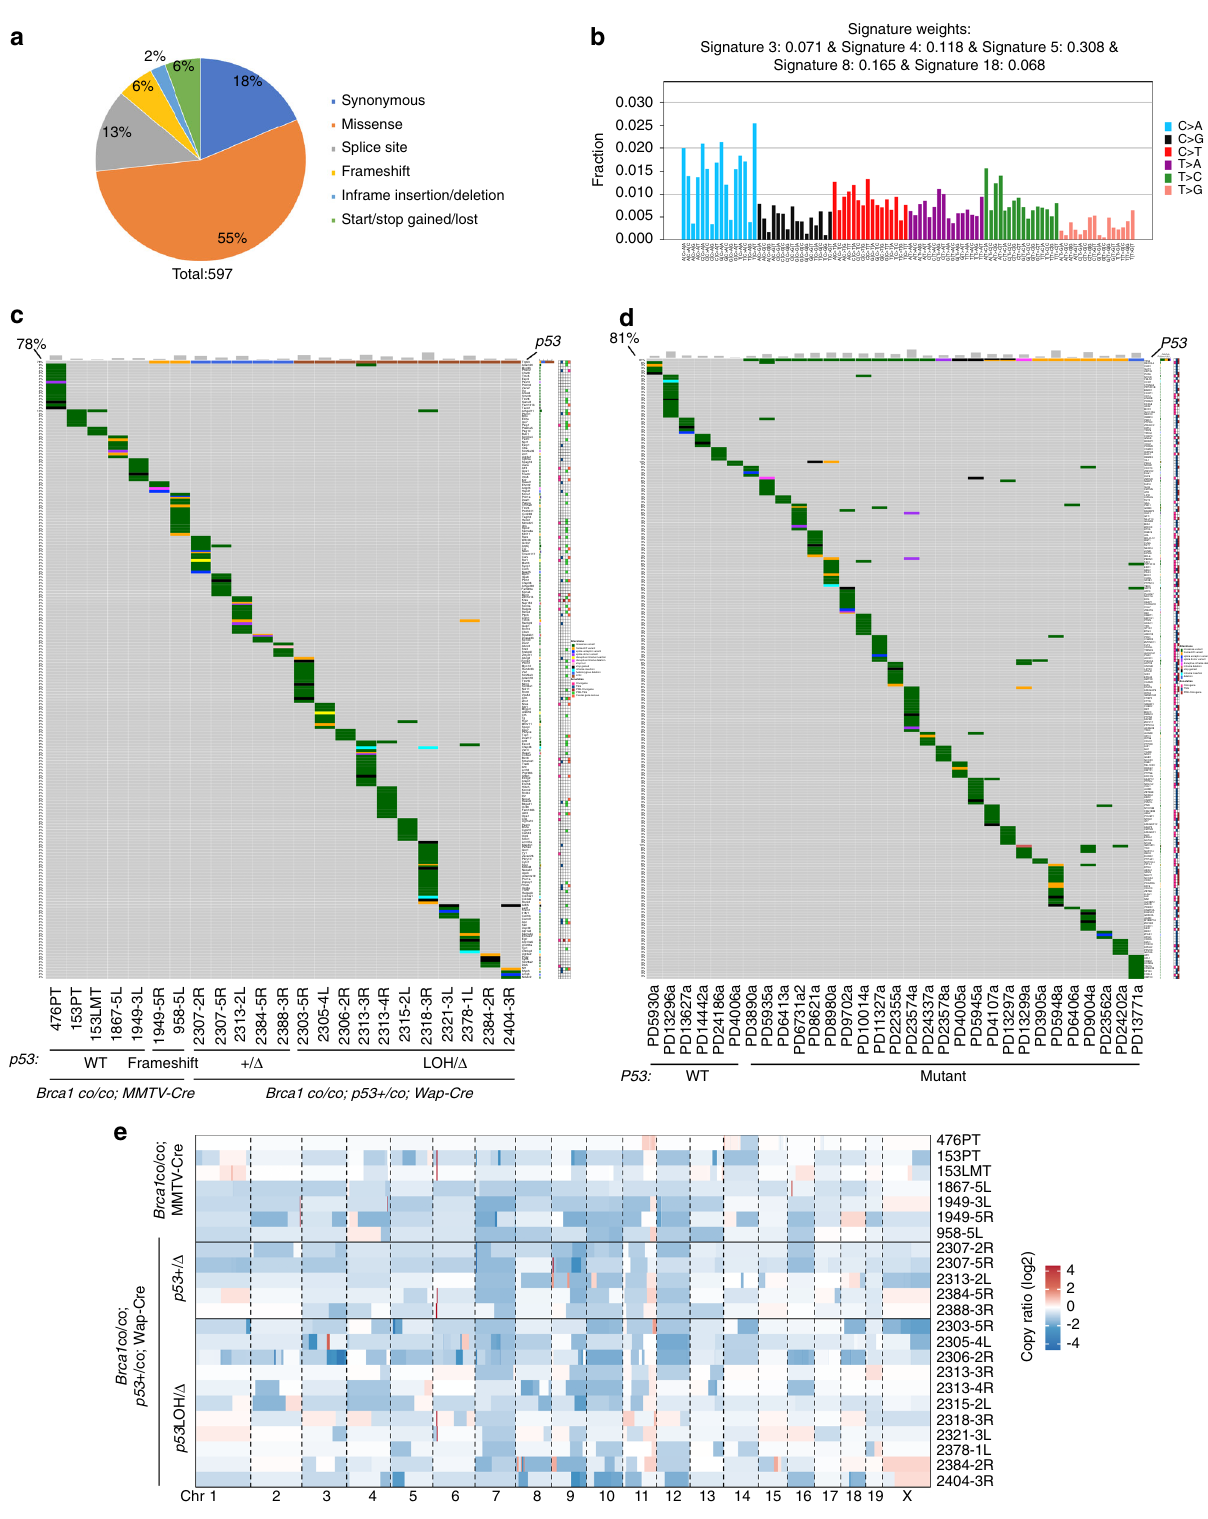
Fig. 1 Unique mutation feature of Brca1 -de fi cient breast tumors revealed by bulk WES. a Mutation types in the coding exon region of Brca1 -de fi cient breast tumors ( n = 23 tumors). b Mutational signature in Brca1 -de fi cient breast tumors ( n = 23 tumors). Mutational signature was generated using all SNVs detected in samples. c Oncoplot summarizing all altered genes with nonsynonymous SNVs in Brca1 -de fi cient breast tumors of Brca1 MKO mice ( n = 23 tumors). PT-primary tumor, LMT-liver metastatic tumor, 5L-tumor in 5th left mammary gland, 5R-tumor in 5th right mammary gland, WT-wild type, + / Δ -deletion of one allele of exon 5 and 6 of p53 mediated by Wap-Cre-LoxP, LOH/ Δ -deletion of two alleles of p53 , one allele deletion is mediated by Wap-Cre-LoxP, another one is naturally lost. d Oncoplot summarizing all altered TSGs or oncogenes with nonsynonymous SNVs in breast tumors of patients with BRCA1 germline mutation from the WSI dataset ( n = 31 tumors). e CNV pro fi les of Brca1 -de fi cient breast tumors of Brca1 MKO mice ( n = 23